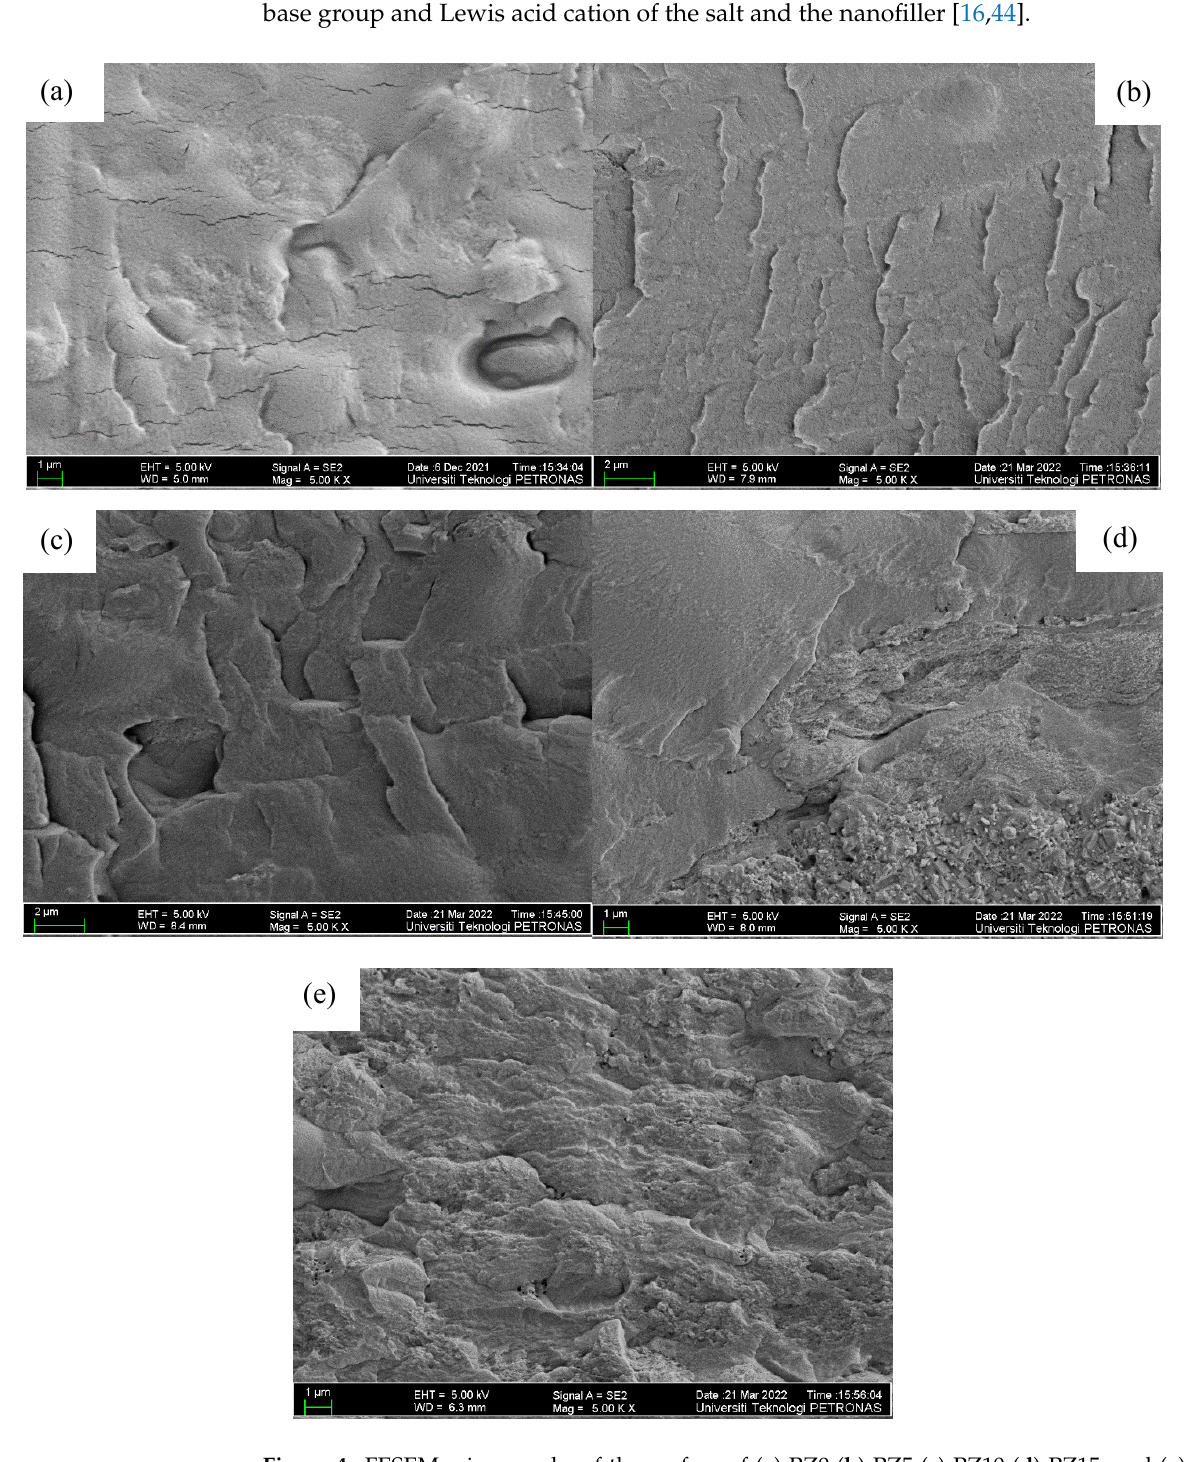
Figure 4. FESEM micrographs of the surface of ( a ) PZ0 ( b ) PZ5 ( c ) PZ10 ( d ) PZ15, and ( e ) PZ20 blend SPEs.